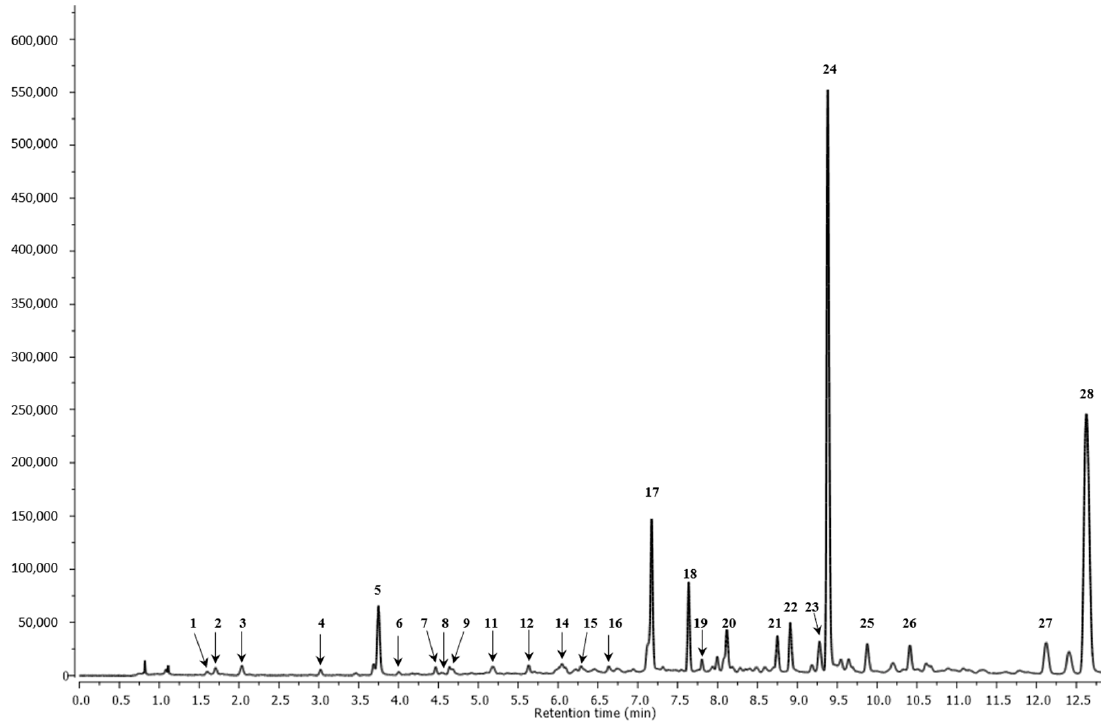
Figure 1. UPLC chromatogram of polyphenolics profile of G. lucidum extract at 280 nm. Peak number identities are displayed in Table 1.